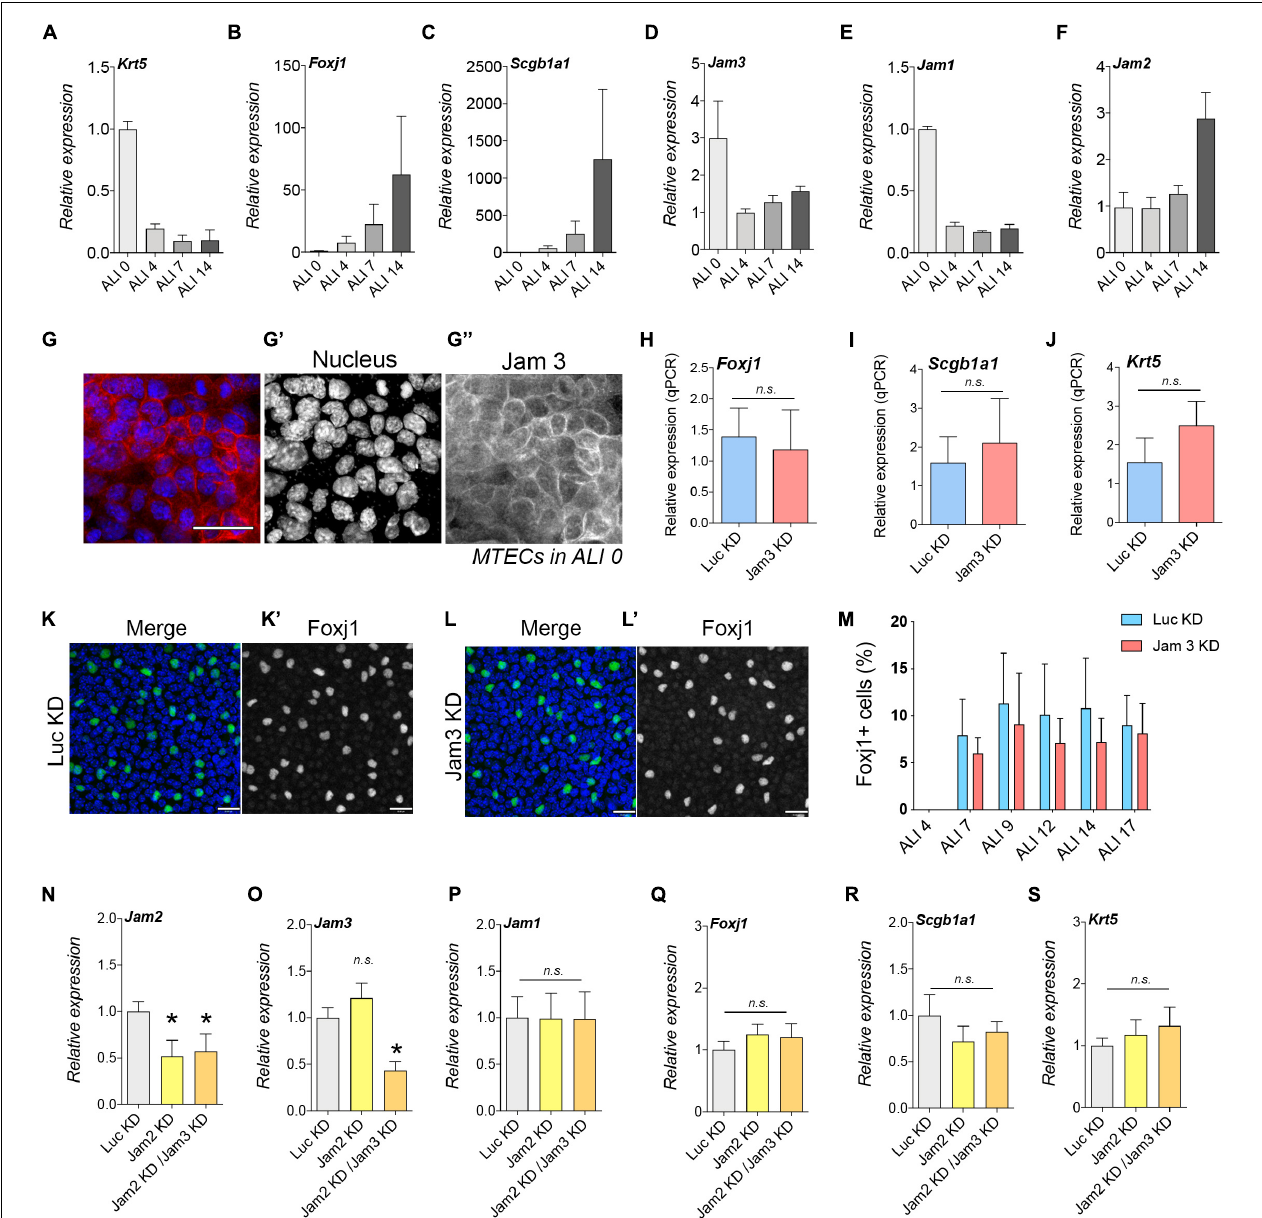
FIGURE 6 | Junctional adhesion molecule 3 (Jam 3) expression varies along the differentiation process but does not affect cell differentiation. (A–C) Quantification of mRNA expression of Krt5 (basal marker, in panel A ), FoxJ1 (multiciliated cells marker in panel B ), and Scgb1a1 (secretory cells marker in panel C ) expression in ALI 0, ALI 4, ALI 7, and ALI14. (D–F) Quantification of mRNA expression of Jam1 (E) , Jam2 (F) , and Jam3 (D) expression in ALI 0, ALI 4, ALI 7, and ALI14. Mean relative to control cells and standard deviation as error bars were plotted for each lineage marker, n = 4. (G) Jam3 immunofluorescence in BSCs during expansion in vitro , nucleus in blue (gray in panel G’ ) and Jam3 in red (gray in panel G” ). (H–J) mRNA expression levels of Krt5 (J) , FoxJ1 (H) , and Scgb1a1 (I) in Luc KD (C) and Jam3 KD (D) MTECs. Mean relative to control cells and standard deviation as error bars were plotted for each lineage marker, n = 4. (K,L) Confocal images for Foxj1 (green in panels K,L and gray in panels K’,L’ ) immunofluorescence in Luc KD (K) or Jam3 KD (L) cells in ALI14. (M) Relative quantification of Foxj1-positive cells along the differentiation process in Luc KD and Jam3 KD cells from ALI 4 to ALI 17. (N–S) Mean mRNA expression levels of Jam3 (O) , Jam1 (P) , Jam2 (N) , Krt5 (D) , Foxj1 (E) , and Scgb1a1 (F) assessed in differentiated MTECs infected with control viruses (Luc KD), Jam2-shRNAs (Jam2 KD), and double knockdown (Jam2 and Jam3), n = 4. Scale bar in panels (G,K,L) represents 20 µ m. p -values in all conditions were obtained using the t -test. * p <